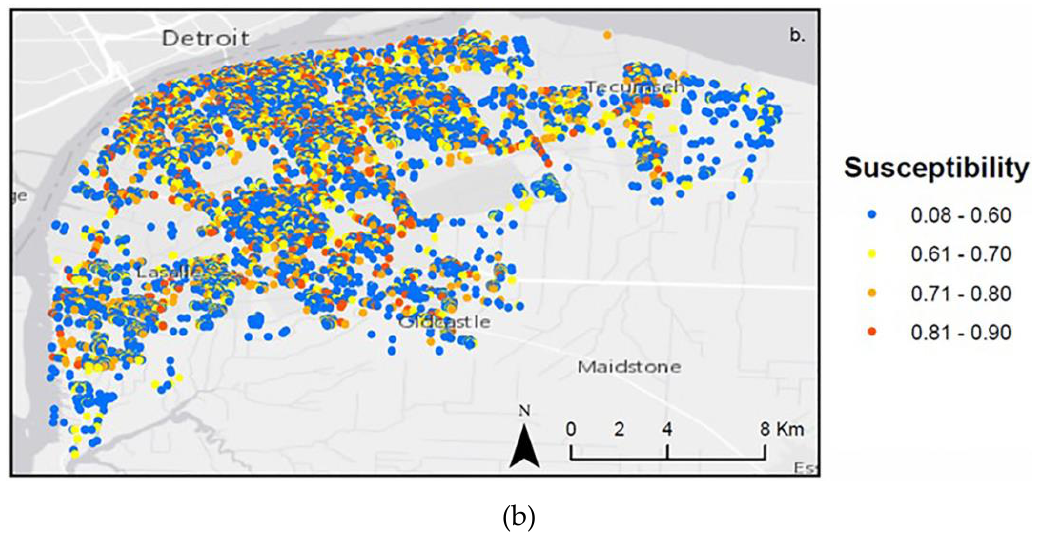
Figure 3. Susceptibility functions for each ash tree representing ( a) (1) distance from infested trees; (2) distance from roads; (3) distance from highways; (4) ash tree density in the stand; (5) ash tree age; (6) ash tree size; (7) wind; and (8) air temperature, combined in ( b ) to produce overall susceptibility. Adult beetles rely on the source of ash tree leaves for food, and, as a result, EAB females prefer to lay their eggs in areas with a higher proportion of ash trees in the stand [42]. This indicates that